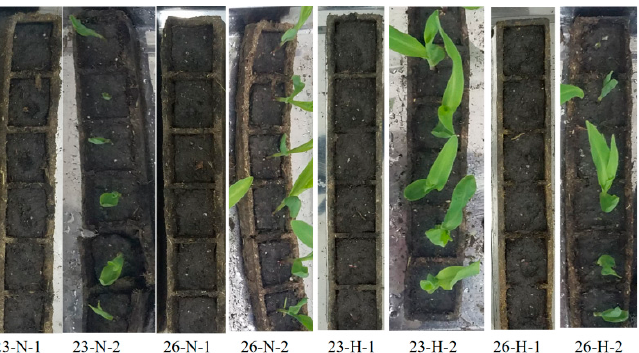
Figure 8. Results of seedling raising in regularly and hot-compressed seedling trays made of material with different moisture contents.